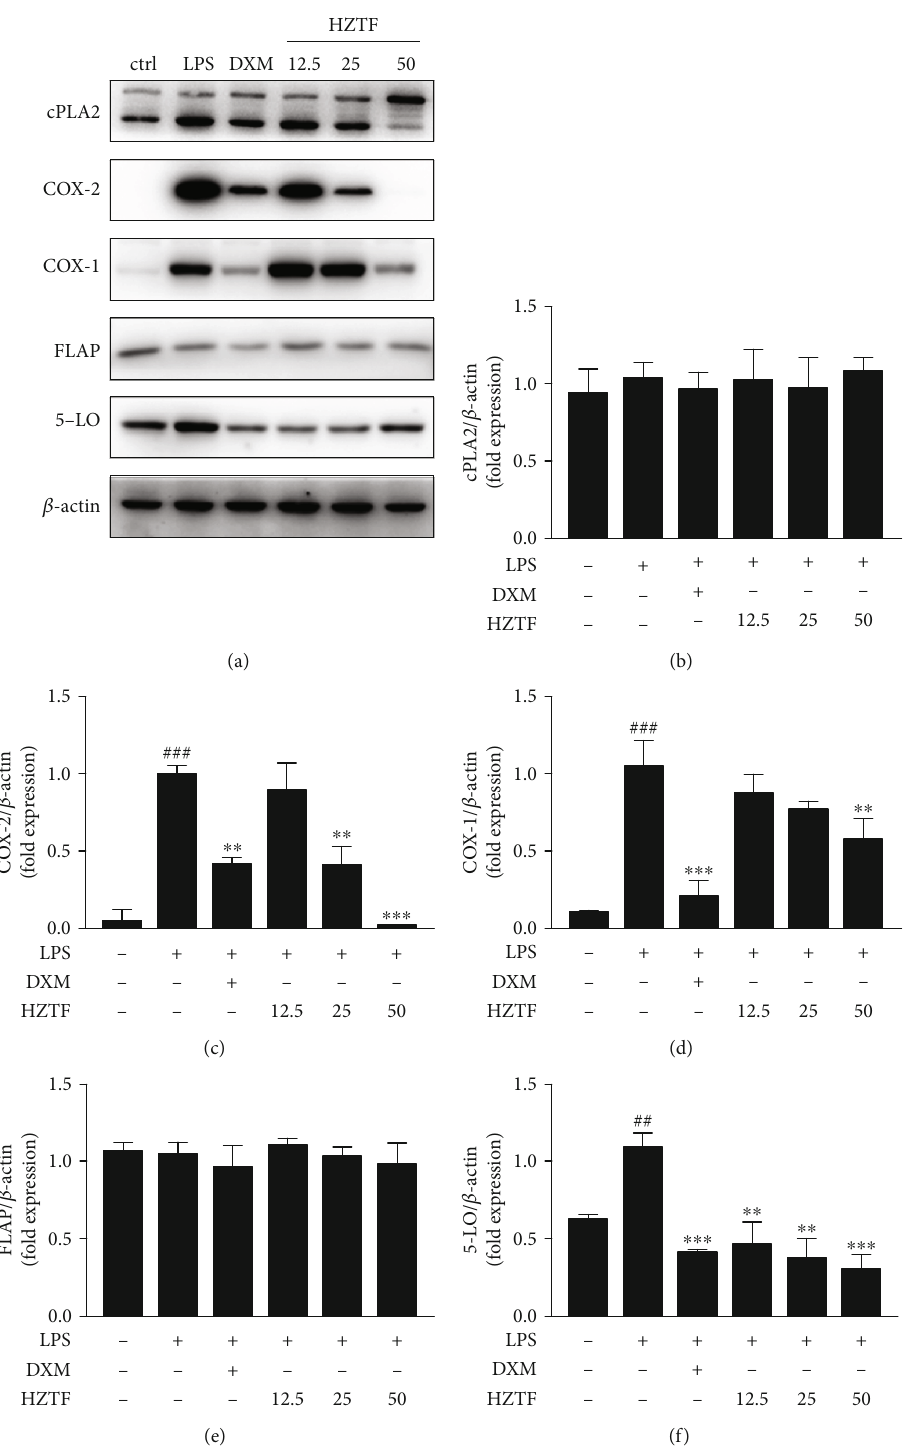
Figure 8: Alterations of the arachidonic acid (AA) pathway in the RAW264.7 cells following HZTF treatment: (a) expression of cPLA2, COX- 2, COX-1, FLAP, and 5-LO by Western blot analysis; (b) the cPLA2/ β -actin ratio; (c) the COX-2/ β -actin ratio; (d) the COX-1/ β -actin ratio; (e) FLAP/ β -actin ratio; (f) the 5-LO/ β -actin ratio. Sample loading was normalized by β -actin. n = 3 ; ## P < 0 : 01 , ### P < 0 : 001 vs. control group; ∗∗ P < 0 : 01 , ∗∗∗ P < 0 : 001 vs. LPS-induced